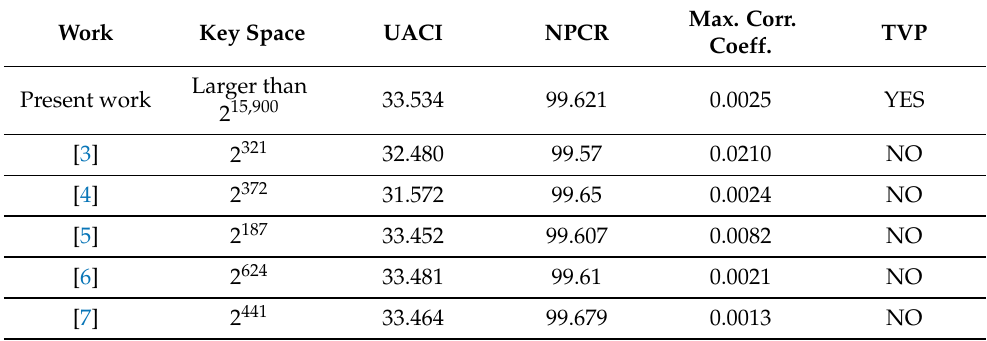
Table 6. Comparison with some encryption schemes in literature for the Baboon image. TVP refers to time-varying parameters and secret